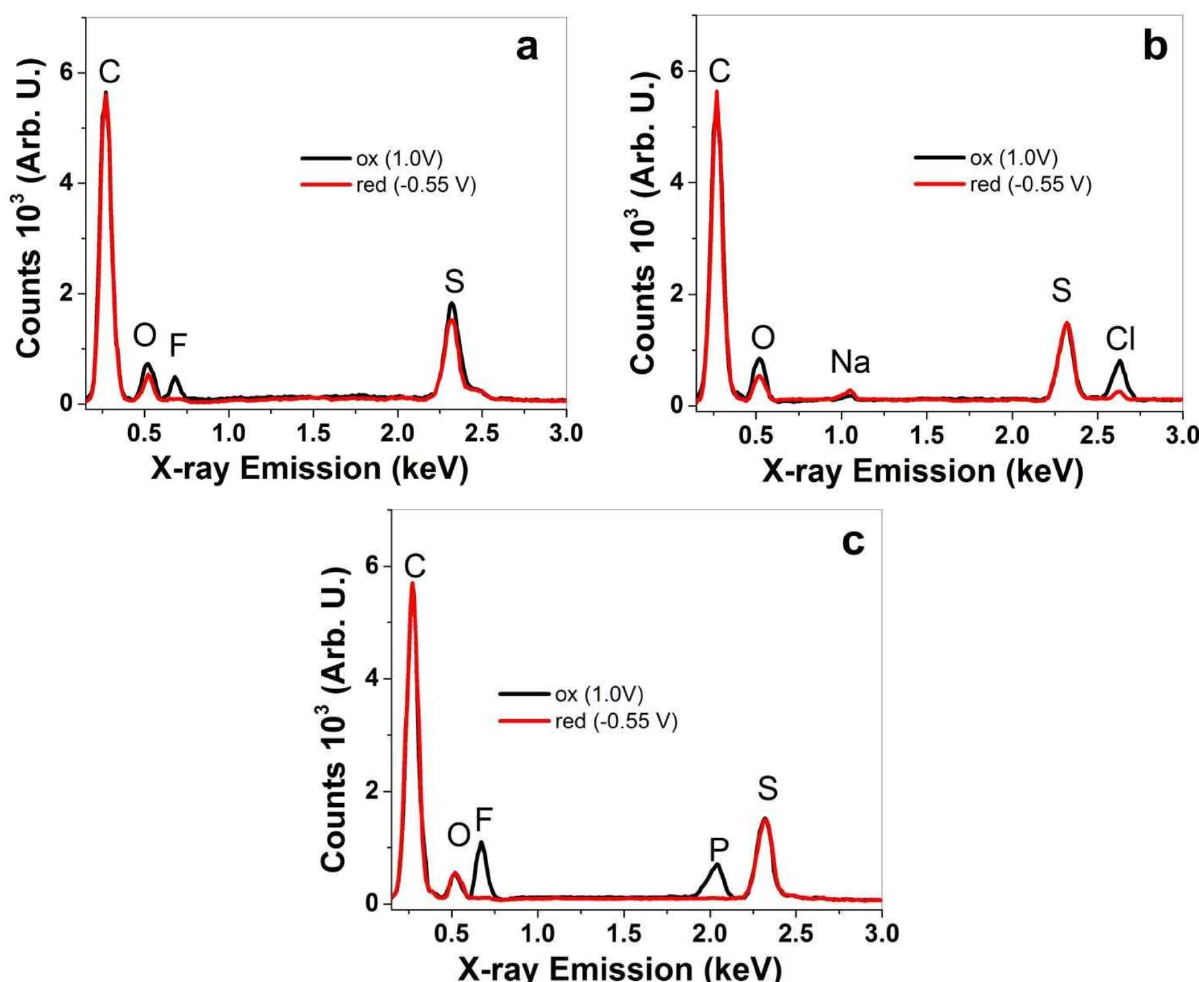
Figure 3. EDX spectroscopy (from cross-section images) of PPy-PEO films after actuation cycles at oxidized state (ox, 1 min, 1.0 V, black line) and reduced state (red, 1 min, − 0.55 V, red curve) in different electrolytes: ( a ) EDMICF 3 SO 3 -PC, ( b ) NaClO 4 -PC and ( c ) TBAPF 6